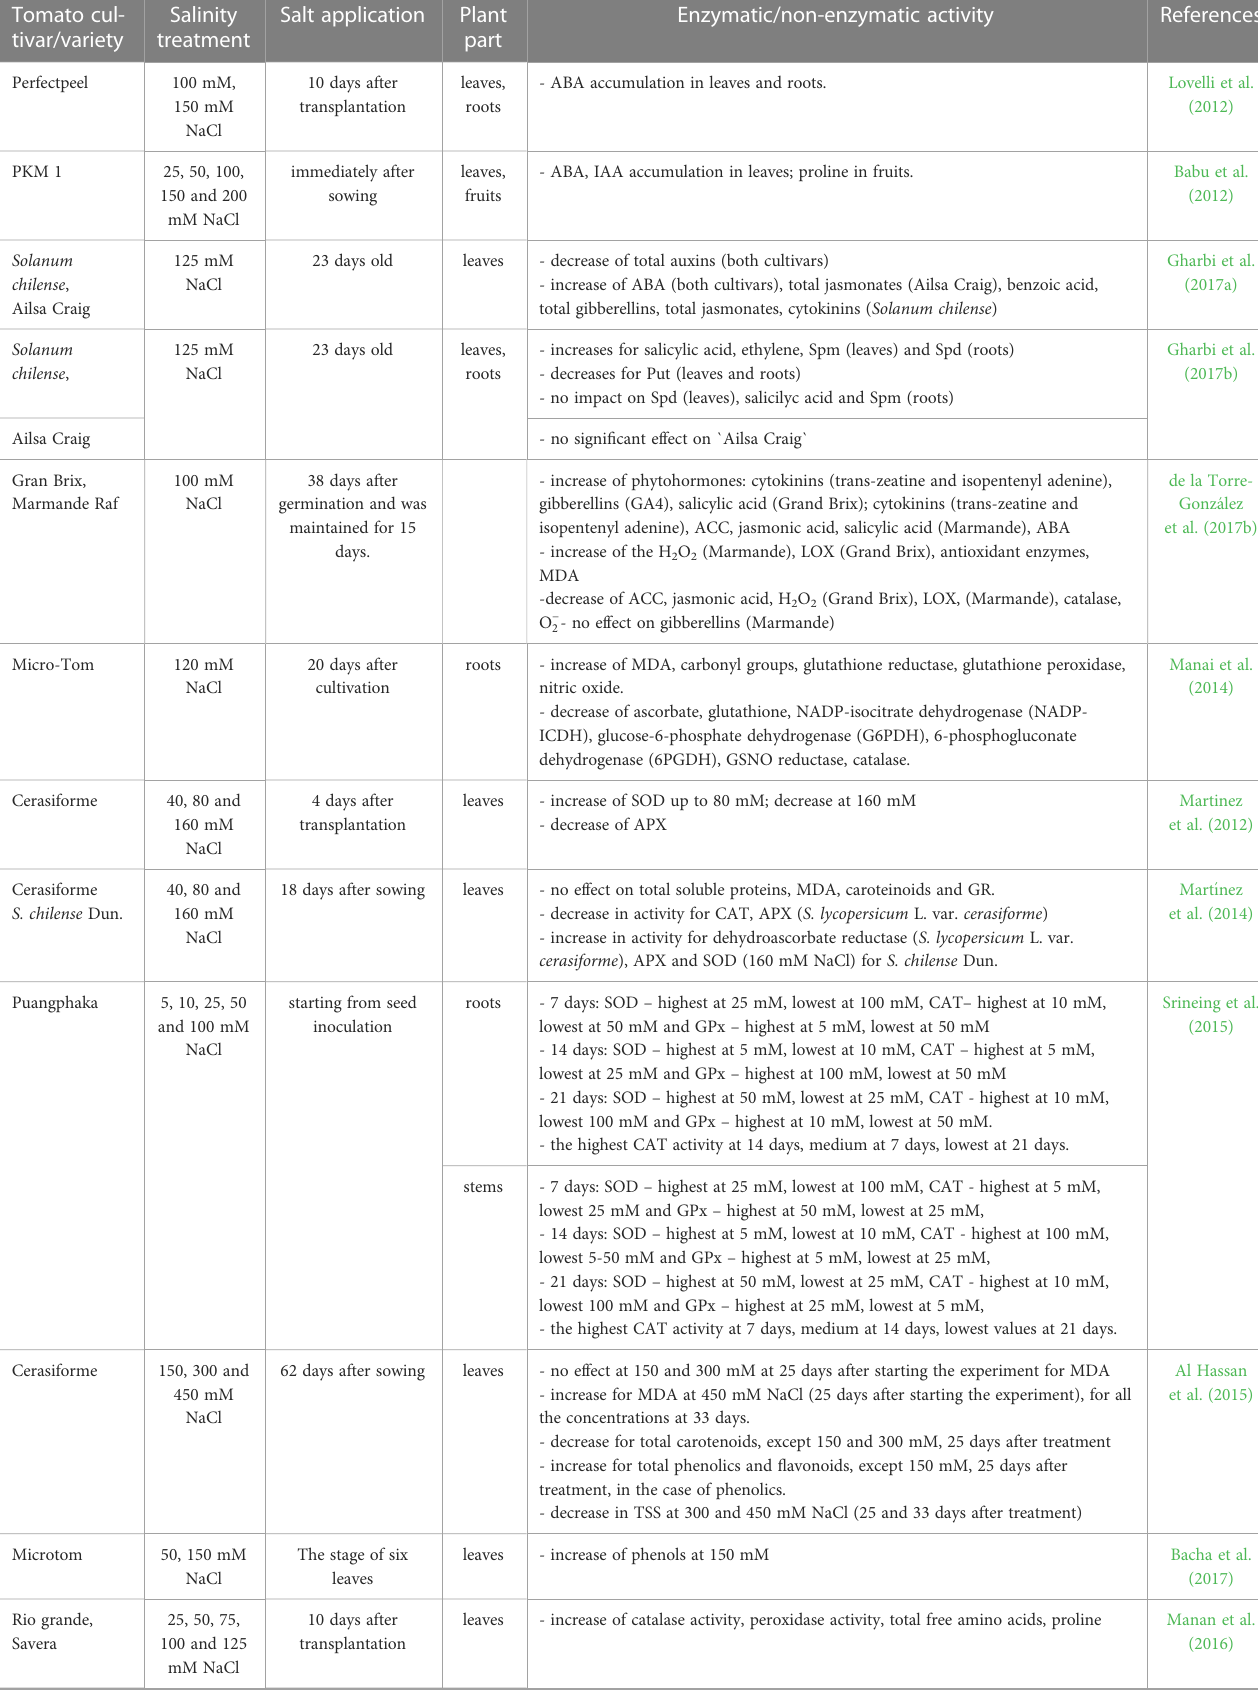
TABLE 4 Salinity impact on the biochemical parameters in tomato plants and